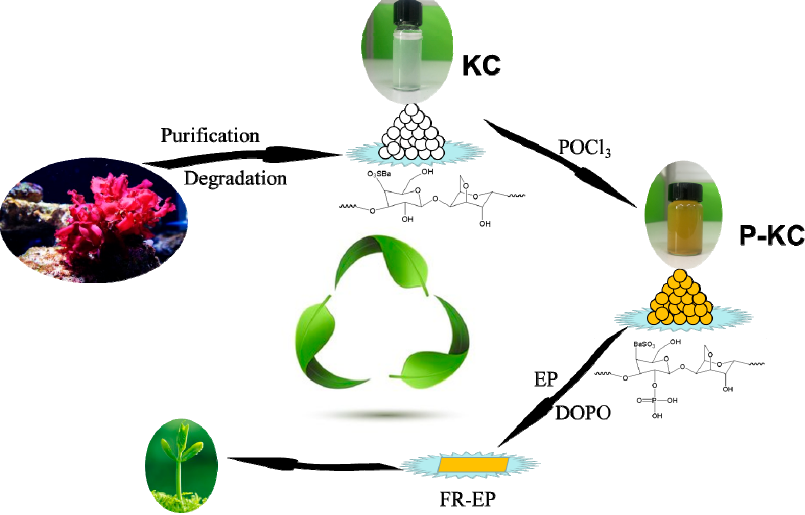
Figure 1. Synthetic route of K-carrageenan (KC) and phosphated K-carrageenan (P-KC), FR-EP. Table 1. Formulations of